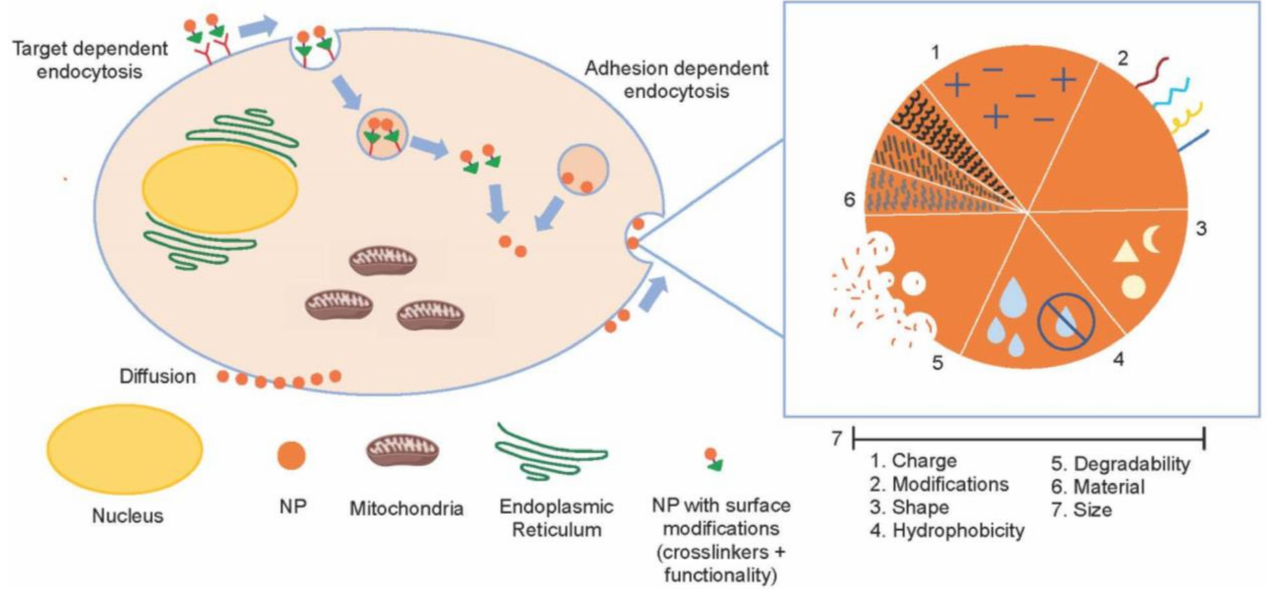
Figure 13. Nanoparticle cancer cell entry via different methods: target-dependent endocytosis, adhesion-dependent endocytosis or penetration, and important parameters for consideration throughout the process of nanoparticle